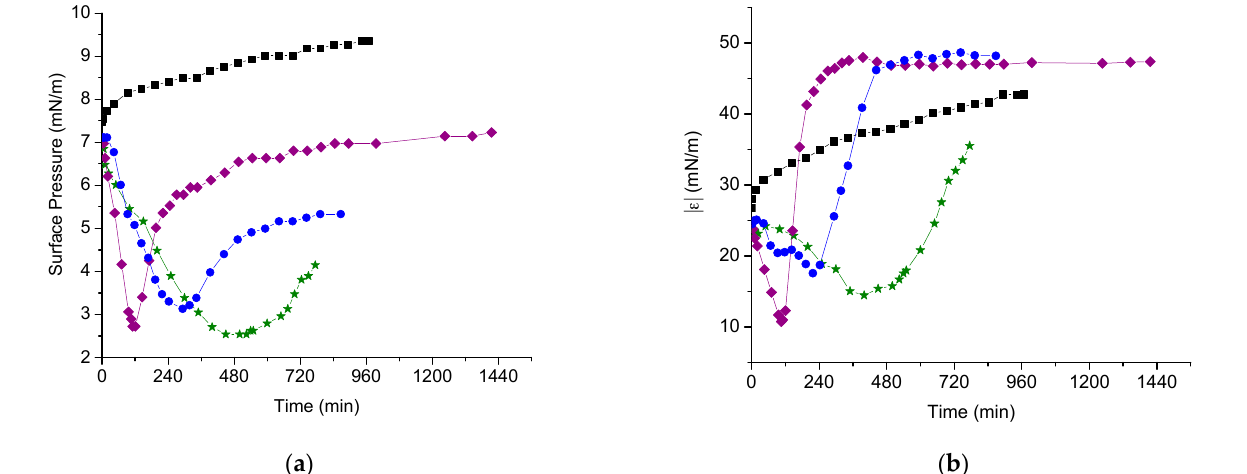
Figure 3. Kinetic dependences of the surface pressure ( a ) and the dynamic elasticity ( b ) of a PDAHMAC layer after DNA injection into subphase. The DNA concentrations in the subphase are 0 (black squares), 14 (green stars), 28 (blue circles) and 56 μ M (purple diamonds). The initial surface pressure of the layer is 7 mN/m. Lines are guides for an eye.